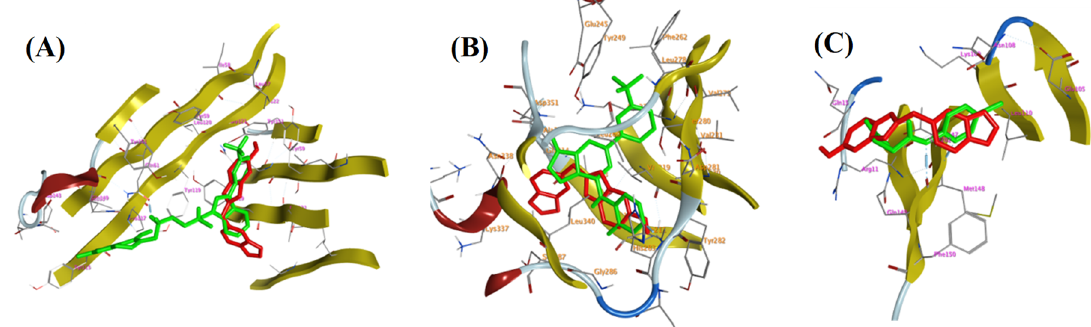
Figure 12. Docking poses of co-crytallized ligand (green) and compound 1 (red) within: ( A ) TNF- α (PDB ID: 2AZ5); ( B ) TGFBR1 kinase (PDB ID: 6B8Y); ( C ) IL-1 β (PDB ID: 6Y8M).